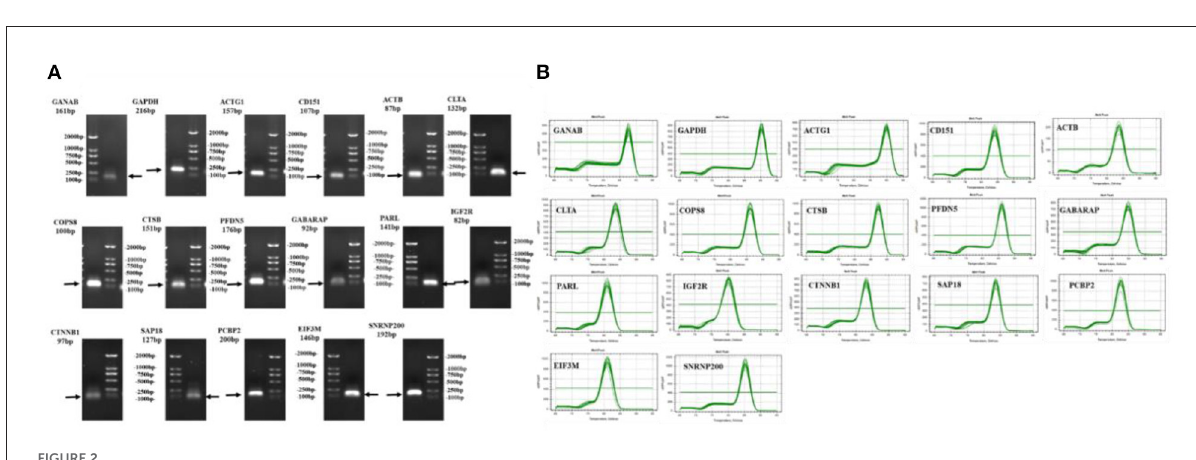
Meridian, USA) was then used to measure the concentration and optical density (OD) ratio of OD260/OD280 of the RNA. RNA integrity was checked using agarose gel electrophoresis